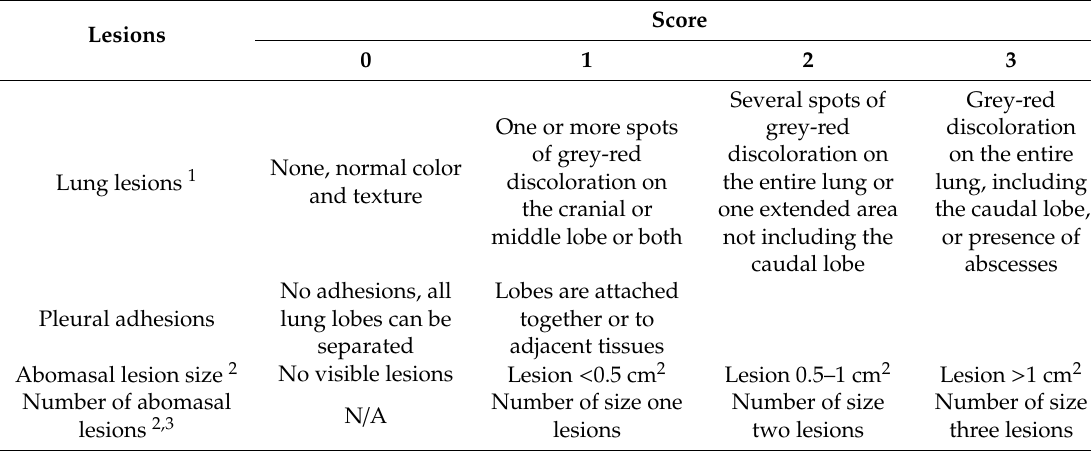
Table 4. Scoring system for lung, pleural and abomasal lesions at